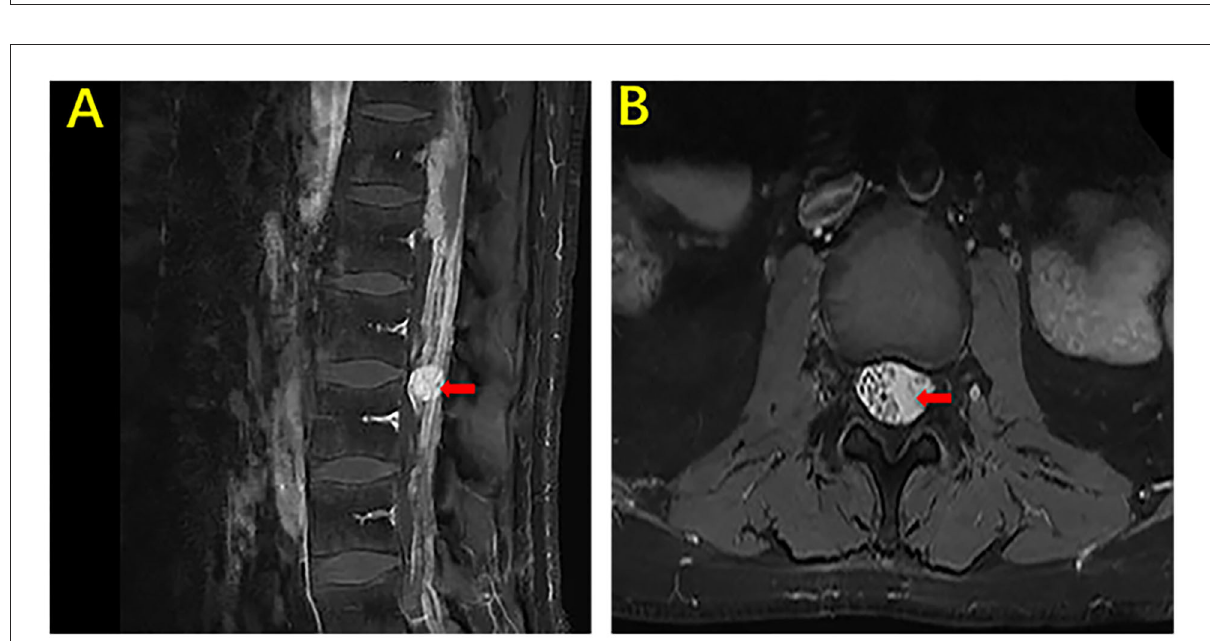
FIGURE3 MRI of the brain and lumbar vertebra of our case. The sagittal section and axial section of the lumbar vertebra showing marked nodular enhancement in the spinal cord at the level of the second lumbar vertebra (arrow) (A) . The axial section of the lumbar vertebra showing marked nodular enhancement in the spinal cord at the same level in picture (A) (arrow) (B) .